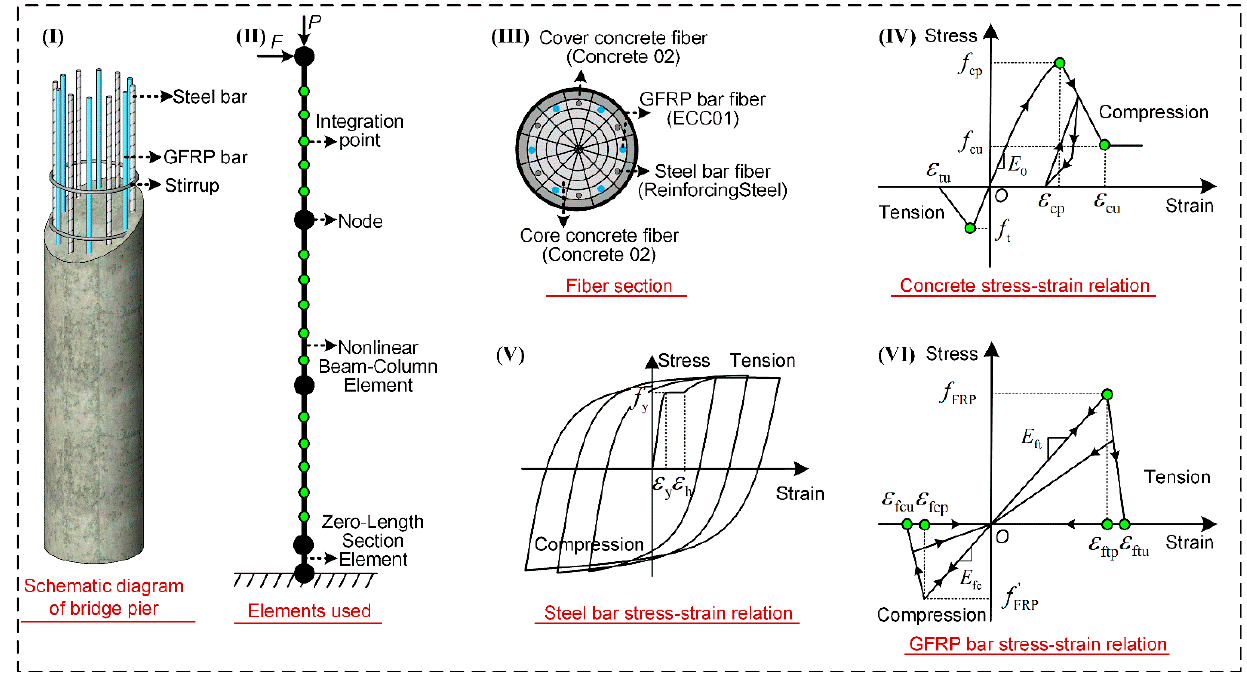
Figure 5. Finite element modeling method.